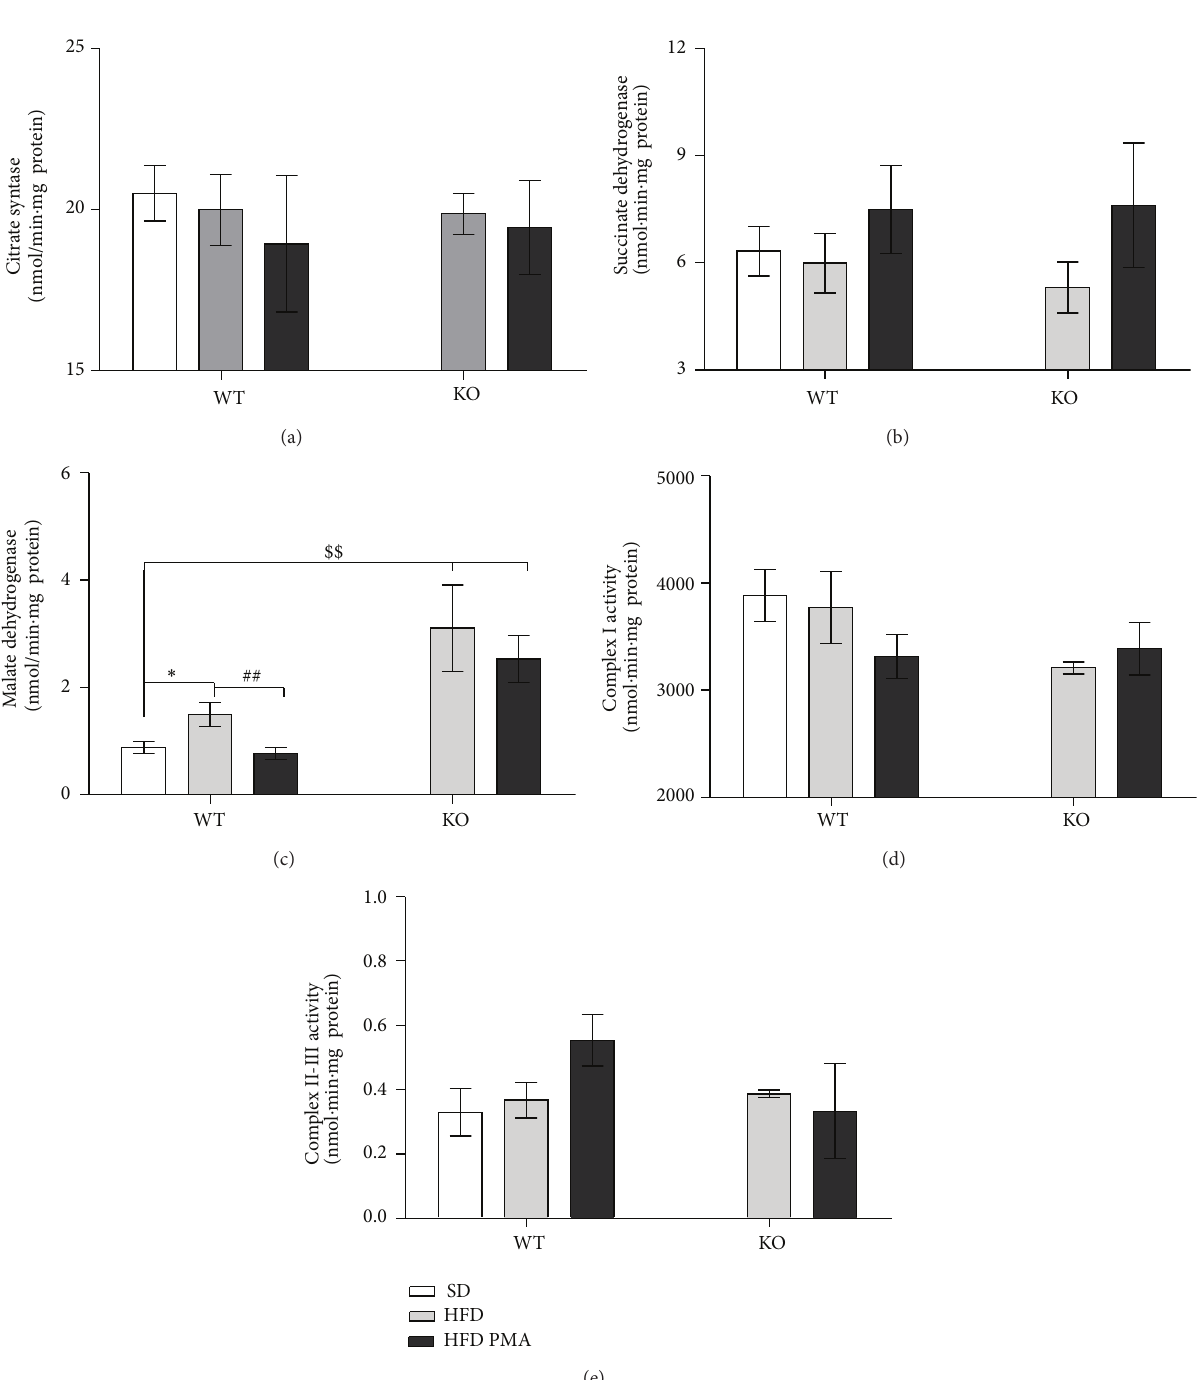
Figure 4: Activity of citrate synthase (a), succinate dehydrogenase (b), malate dehydrogenase (c), complex I (d), and complex II-III (e) in WT mice fed with standard diet (SD) or C57 and PPAR 𝛼 -knockout (KO) mice fed with a high-fat diet and treated with oleic acid (HFD) or palmitoleic acid (HFD PMA). The data are presented as mean ± SEM. ∗ 𝑃 < 0.05 versus WT SD; ## 𝑃 < 0.01 HFD versus HFD PMA; and $$ 𝑃 < 0.05 KO versus the respective C57 control (one-way ANOVA followed by Bonferroni